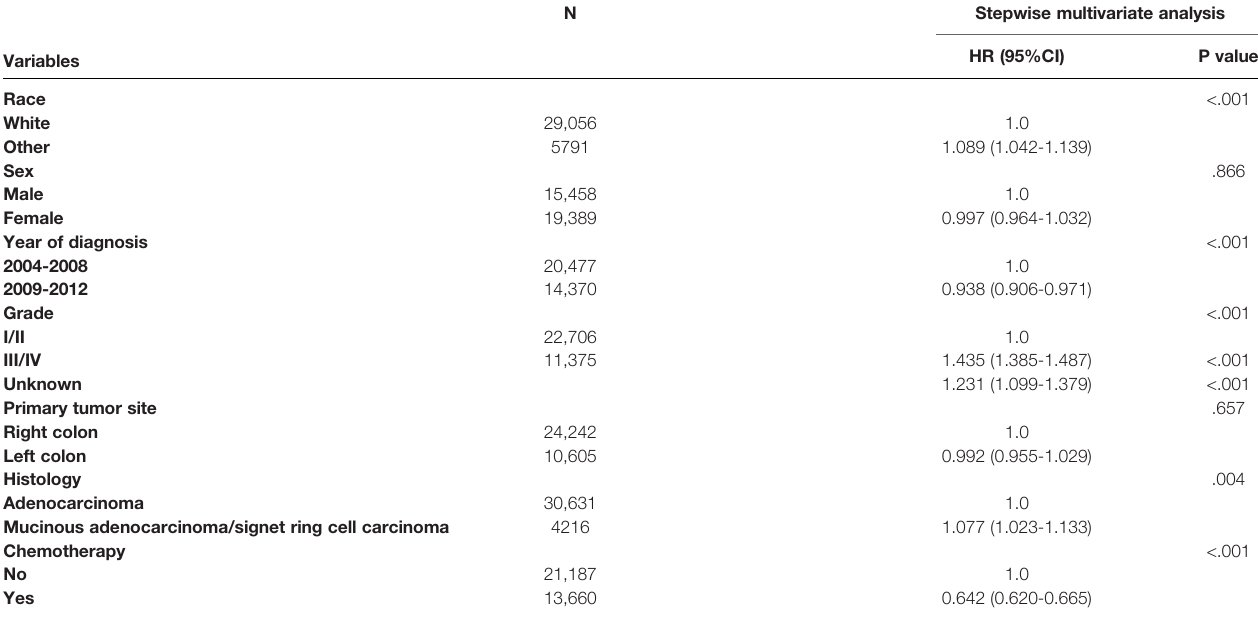
N Stepwise multivariate